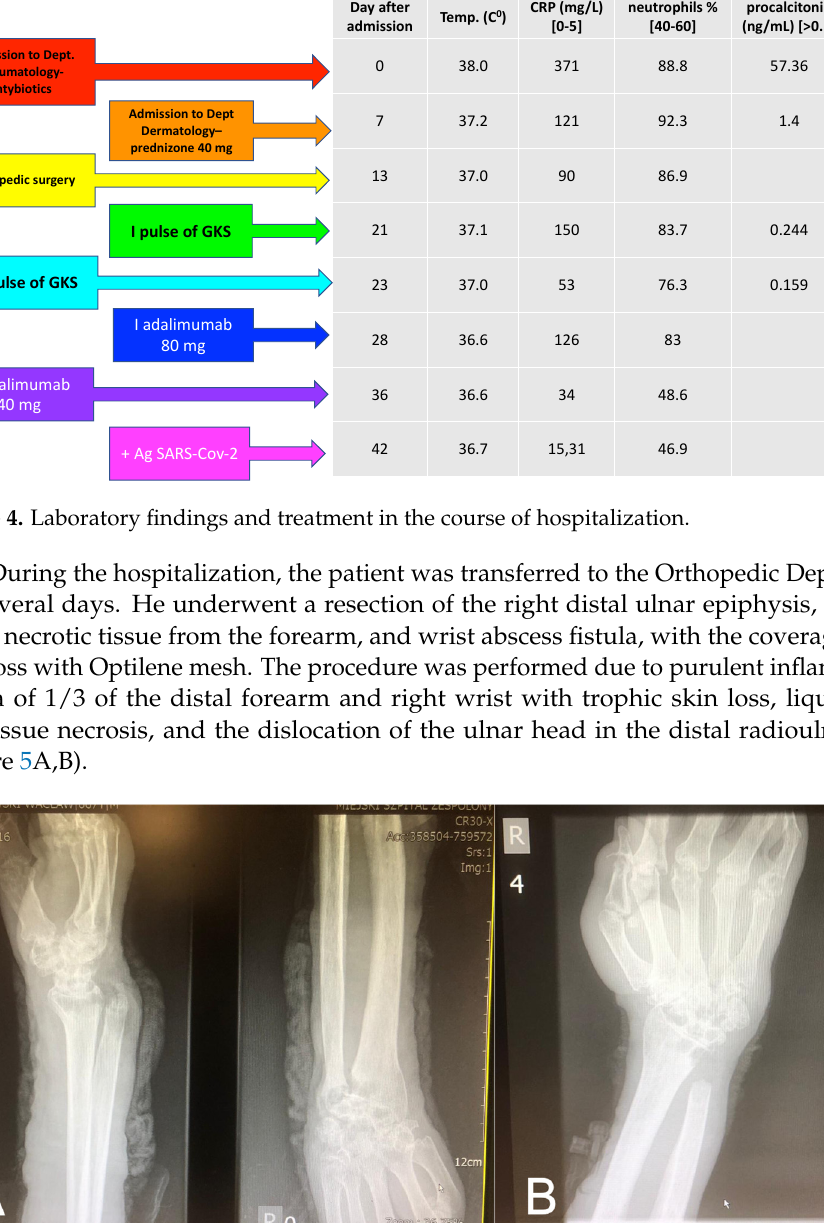
Figure 5. ( A ) X-ray of the right upper limb—subluxation of the wrist, contour deformity with a